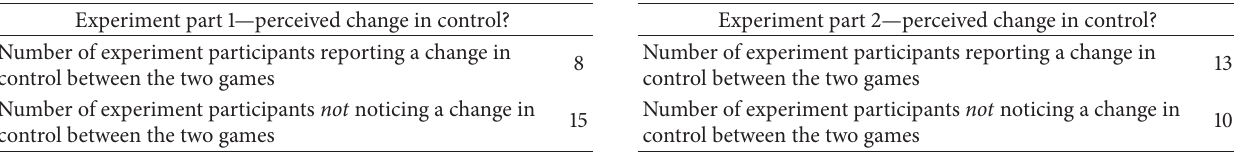
Table 9: Numbers of experiment participants that described either